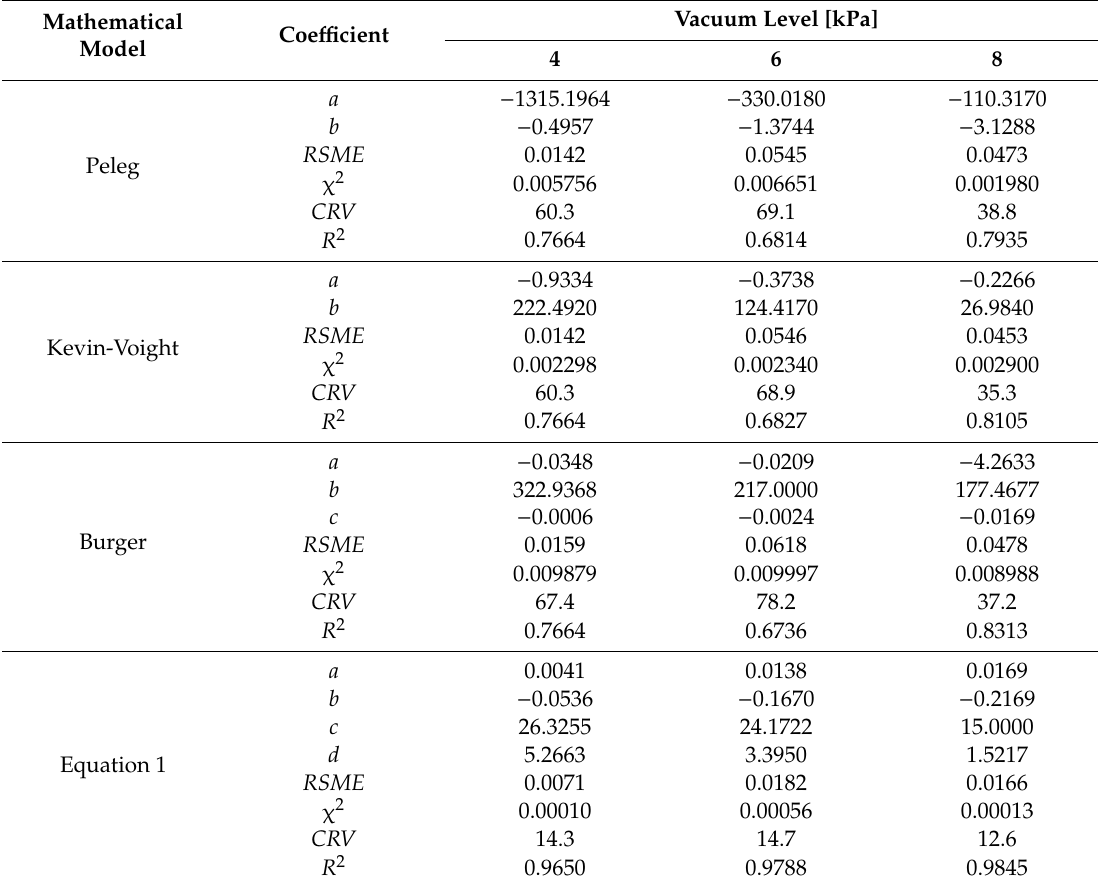
Table 5. Statistical factors in mathematical models fitting the experimental data of SG changes during VI of apples at varied vacuum pressures of 4, 6, and 8 kPa using distilled water as the impregnating